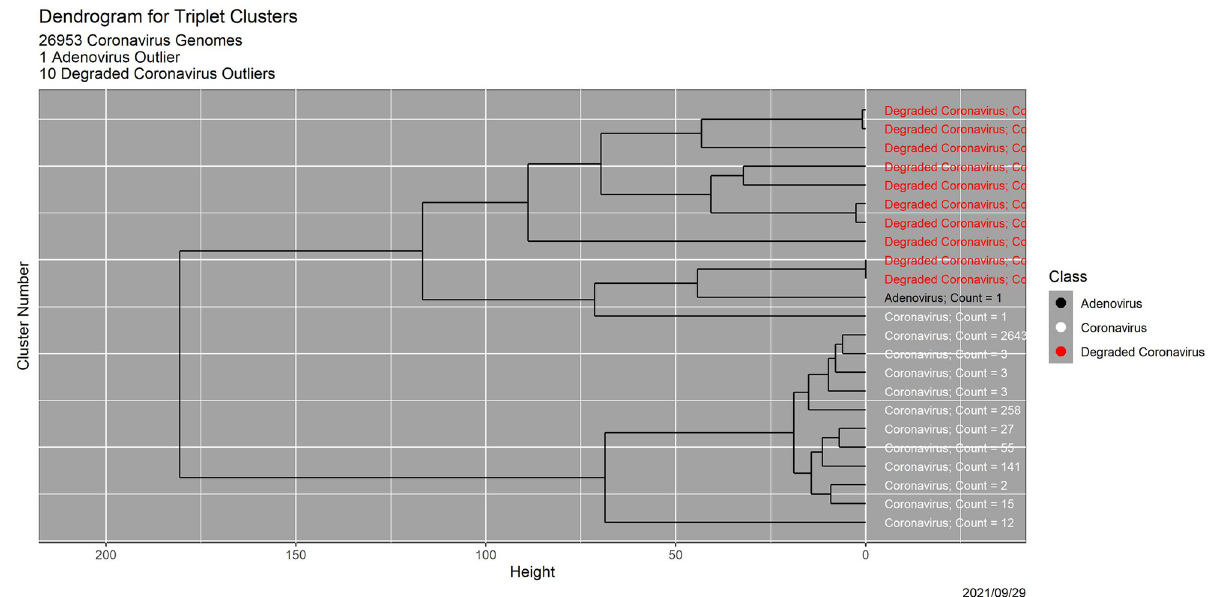
Fig 7. Results for triplet distribution clustering. Dendrogram, in which clusters are in order from 1 at the bottom to 23 at the top. Colors are the same as in Fig 6.